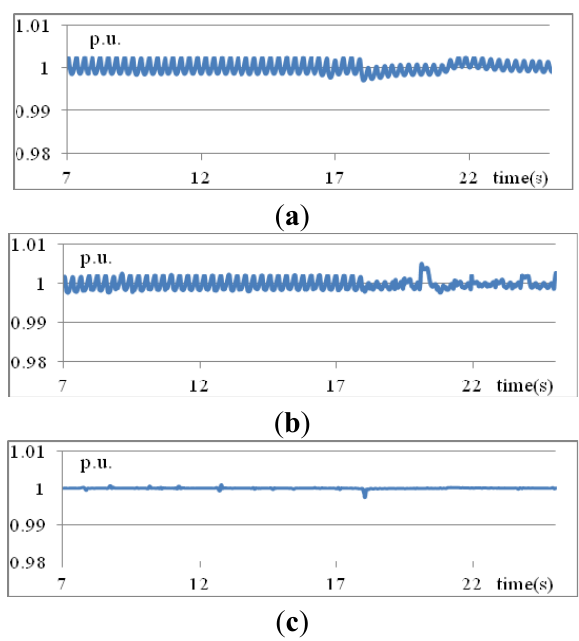
Figure 10. Voltages at bus 3 obtained using three methods: ( a ) traditional PID; ( b ) T1 fuzzy rules; and ( c ) IT2 fuzzy rules (Scenario